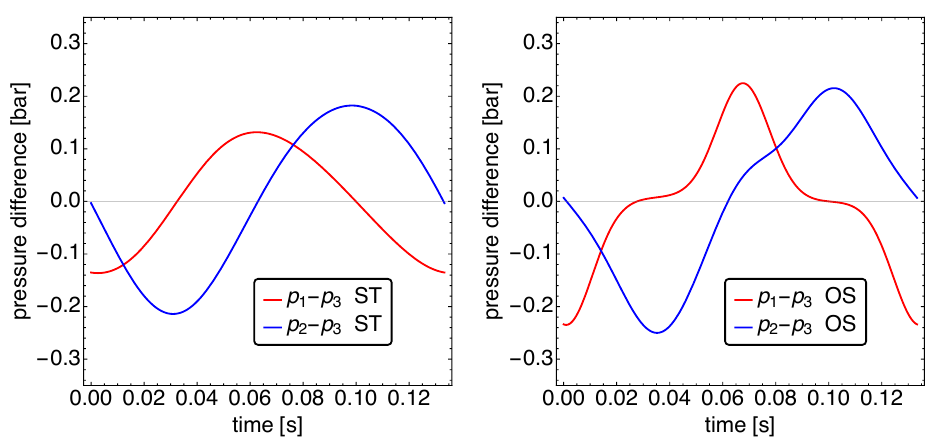
− p − p p 1 3 and 2 3 across the hot and cold piston vs. time during